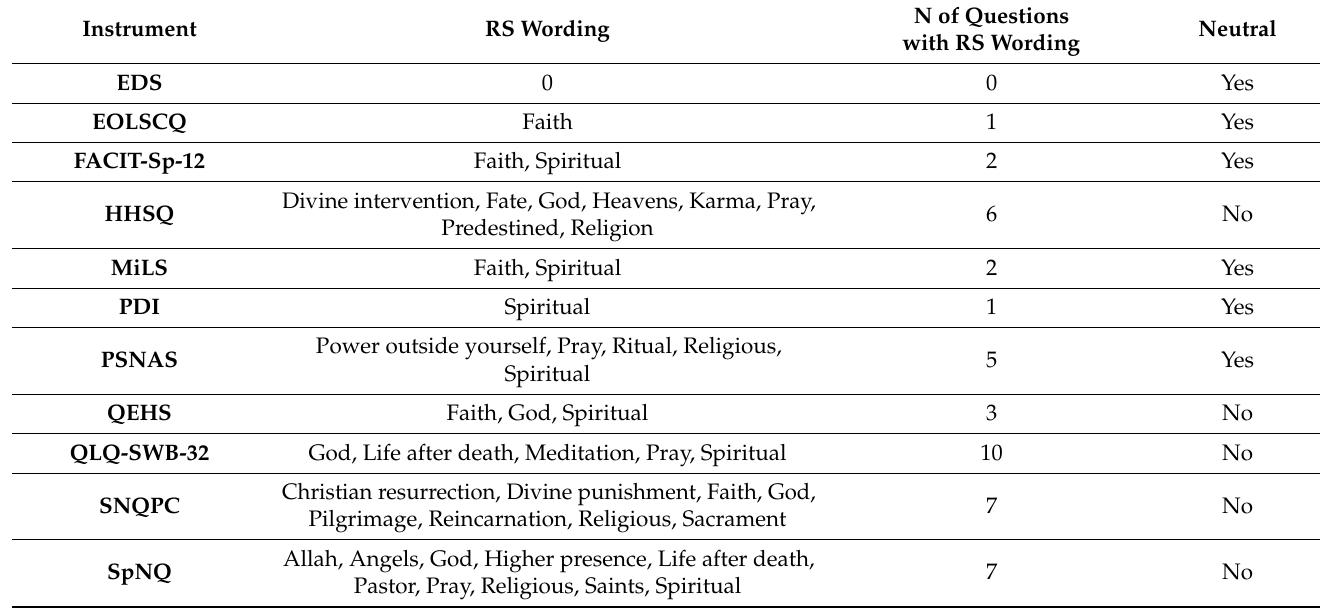
Table 6. Secular